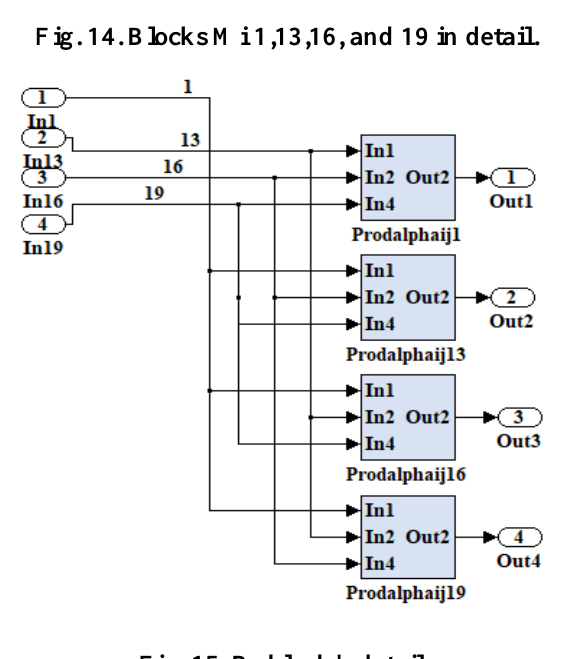
Fig. 15. Pr block's